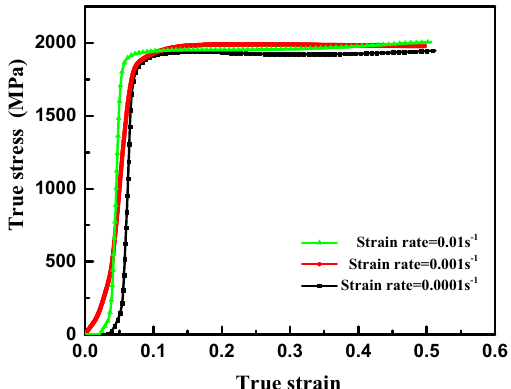
Figure 3. True stress–strain curves of iron–nickel based ultra-high strength steel from quasi-static compression tests.